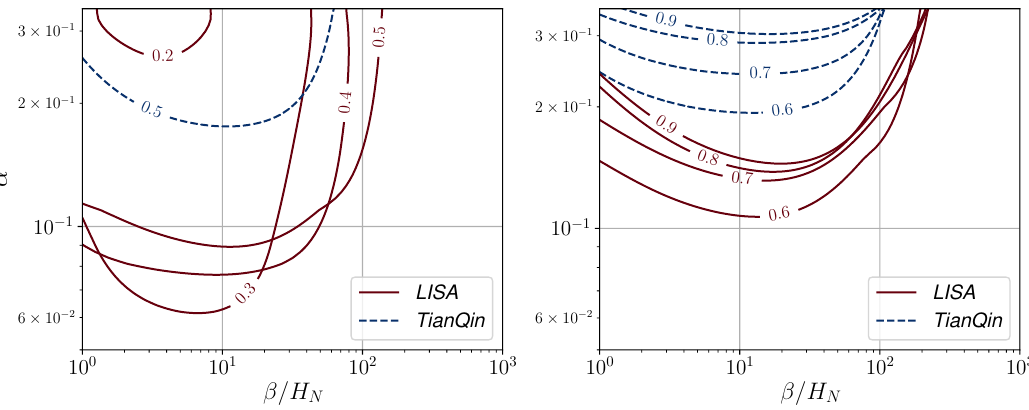
Figure 11 . Curves of constant wall speed v w in the α − β plane for LISA and TianQin Ω gw , exp , with dark red and dark blue lines representing the detectable signal-to-noise ratio limit of 10 for each wall velocity. The left plot displays wall speeds of v w = 0 . 5 and below, and the right plot displays wall speeds of v w = 0 . 6 and above, with the area contained above each line being theoretically detectable for that wall velocity, which is labeled on the line itself. The curve for wall velocity v w = 0 . 1 for TianQin is not detectable in the range of transition strengths shown, and the temperature used for this plot is T N = 500 GeV.